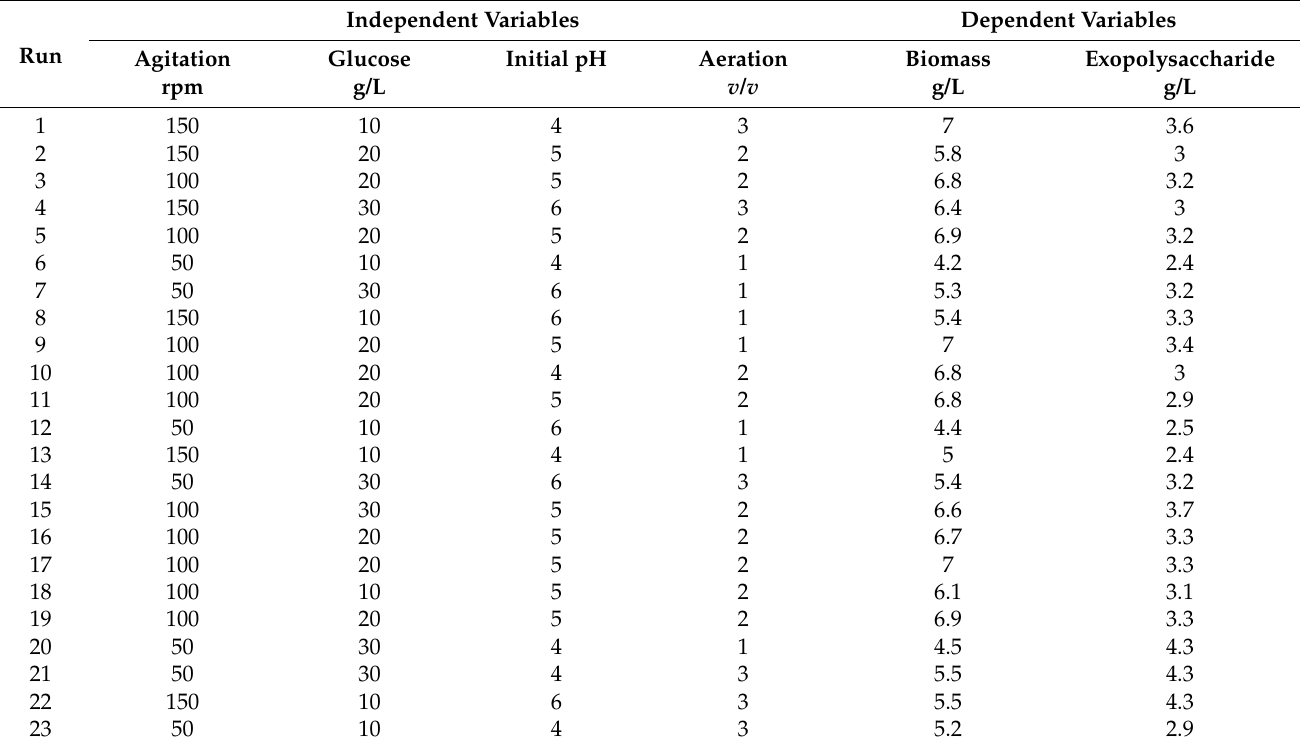
Table 3. RSM design matrix with Central Composite Design (CCD) and responses utilised to